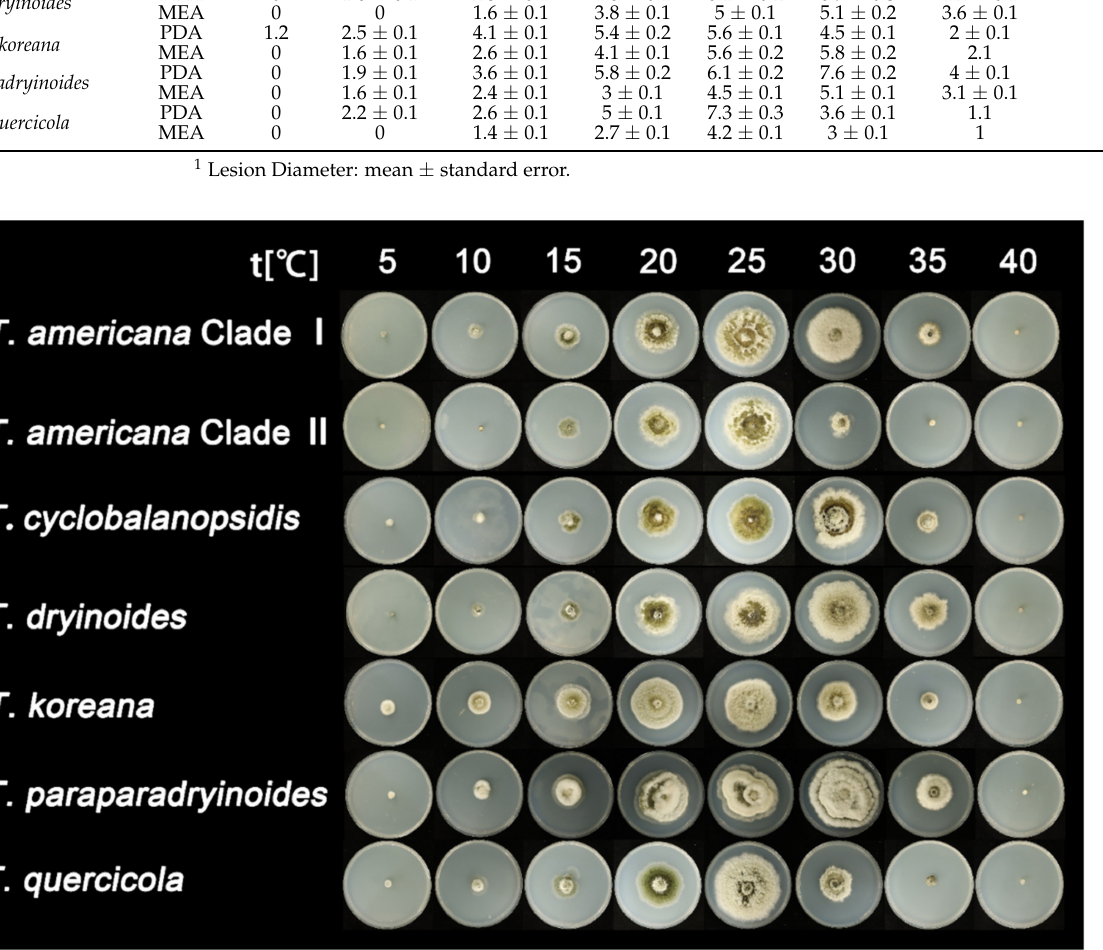
Figure 2. The effect of temperature on the mycelial growth rate of six Tubakia species on PDA after seven days of